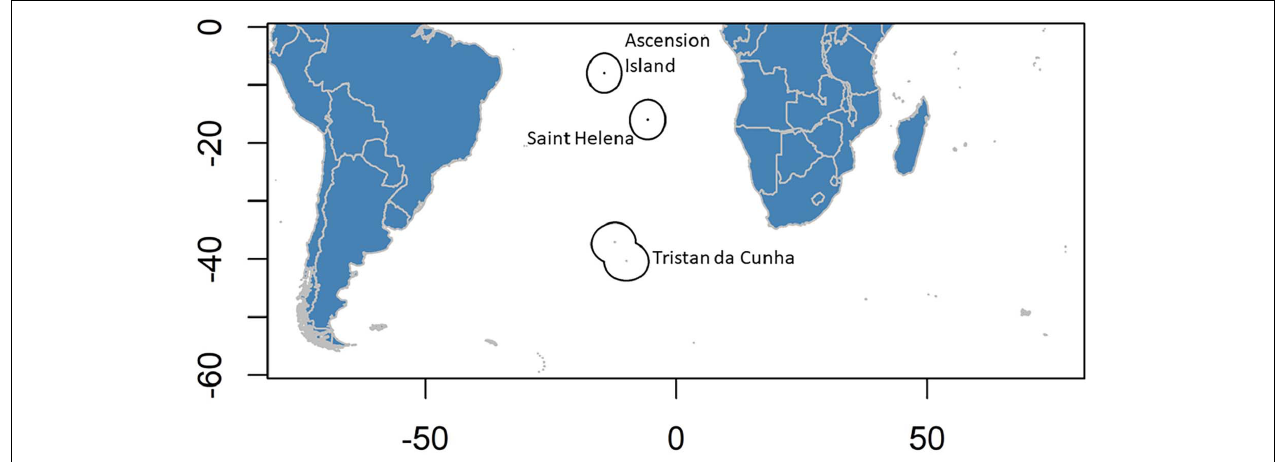
FIGURE 1 | Location map of the EEZs of the UK Overseas Territories in the South